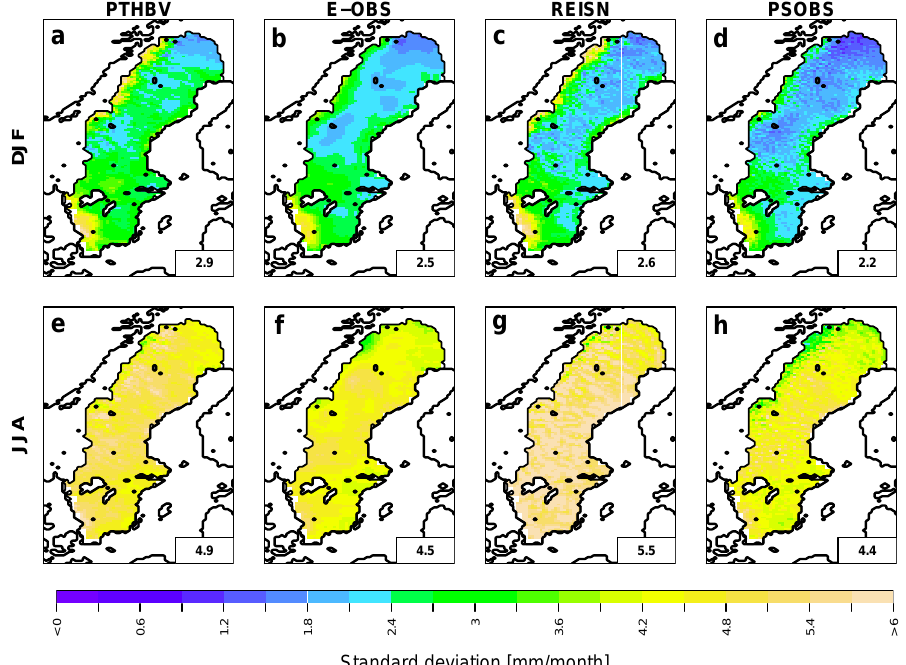
Same as Figure 2, but for intra monthly standard deviation (see main